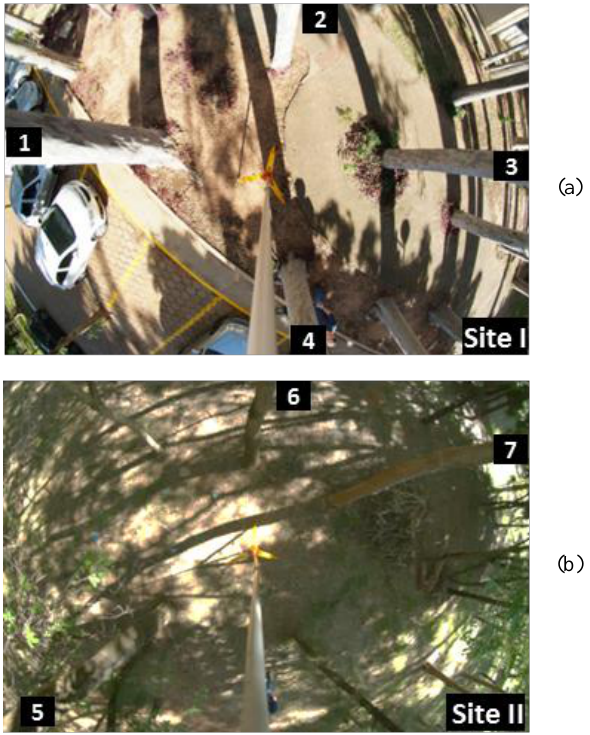
Figure 4. Fisheye vertical images collected from two sites with identification of the trunks used in the